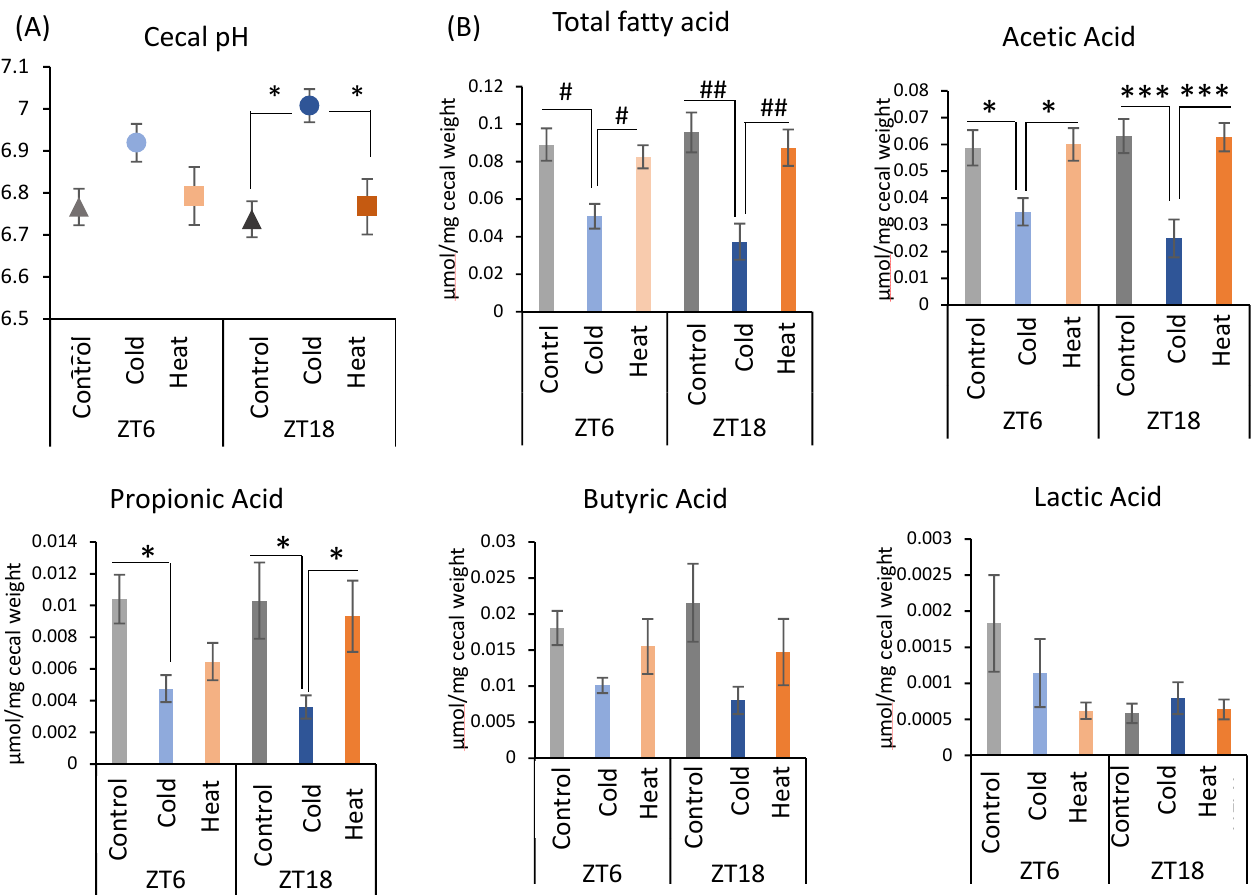
Figure 3. Effects of cold or heat exposure on gut environment. ( A ) Cecal pH; ( B ) SCFAs (total SCFA, acetic acid, propionic acid, butyric acid, lactic acid) of mice were exposed to 22 or 7 or 37 °C for 3 h at each point (ZT6, 18) for 10 days. Data are represented as mean ± SEM ( n = 7). # p < 0.05, ## p < 0.01 evaluated using the Kruskal–Wallis test with a two-stage linear step-up procedure of the Benjamini, Krieger, and Yekutieli test for multiple comparisons. * p < 0.05, *** p < 0.001 evaluated using two-way ANOVA with Sidak’s post hoc analysis.